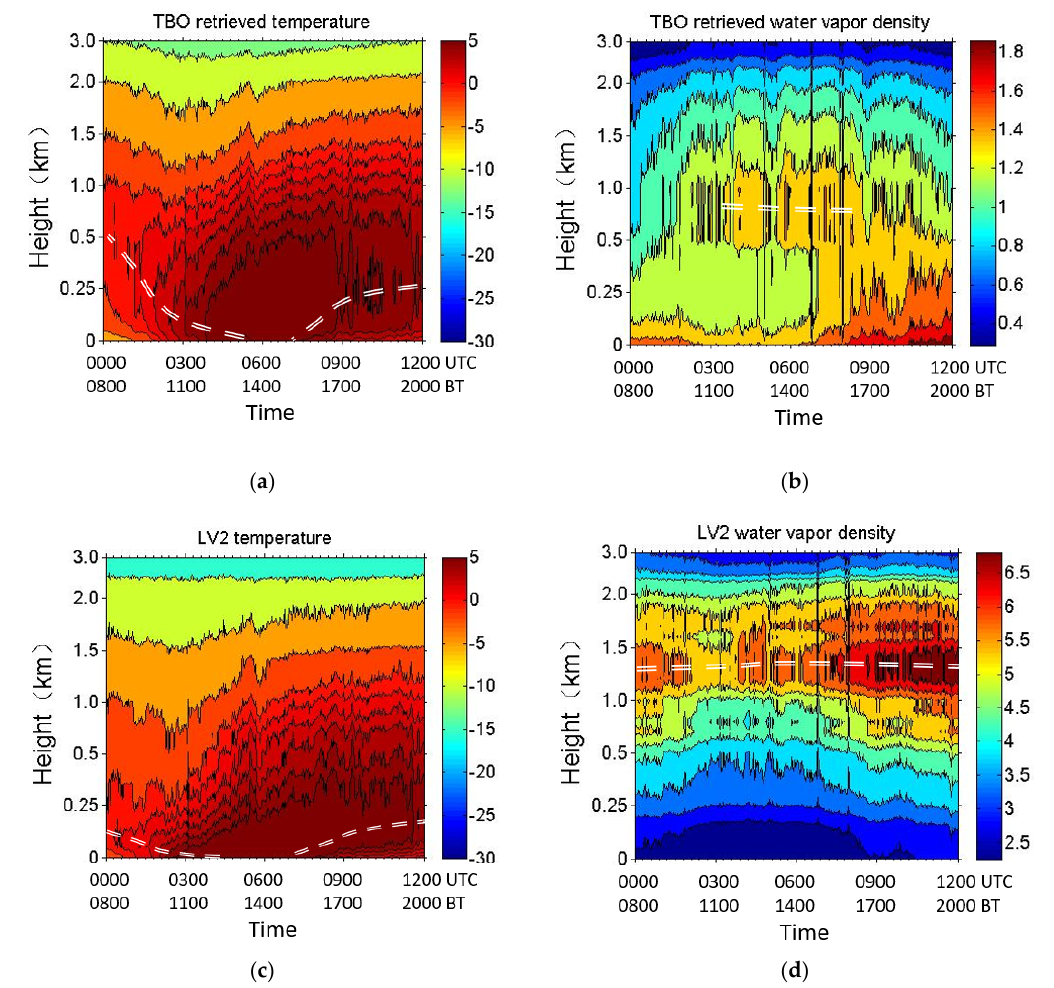
Figure 4. Temperature and humidity profiles with a 2-min resolution during 0000–1200 UTC (0800–2000 BT) on 18 December 2010, supplied by this study as compared with LV2. ( a ) temperature retrievals from TB O ; ( b ) water vapor density retrieval from TB O ; ( c ) temperature (°C) of LV2; ( d ) water vapor density (g/m 3 ) of LV2.